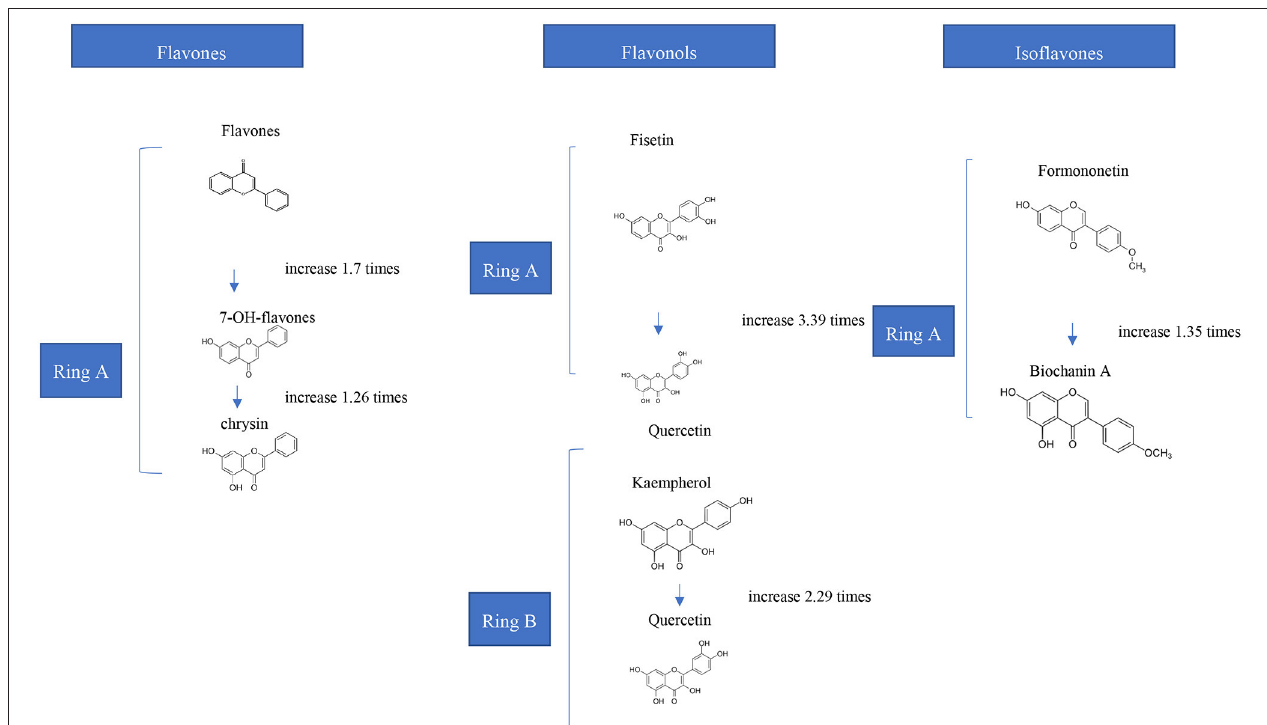
FIGURE 1 | Effects of Hydroxylation of Flavonoids on the Affinities for Bovine Hemoglobin in vitro (24).